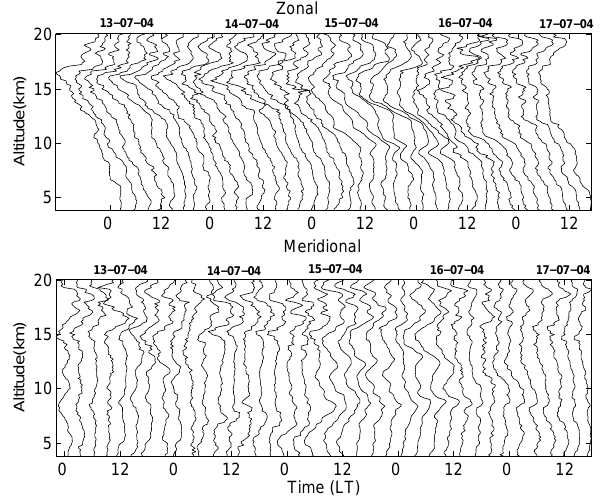
Fig. 5. Latitude-longitude distribution of the satellite brightness temperature (TBB) observed on 15–16 July 2004, for a few hours around 22:00LT.